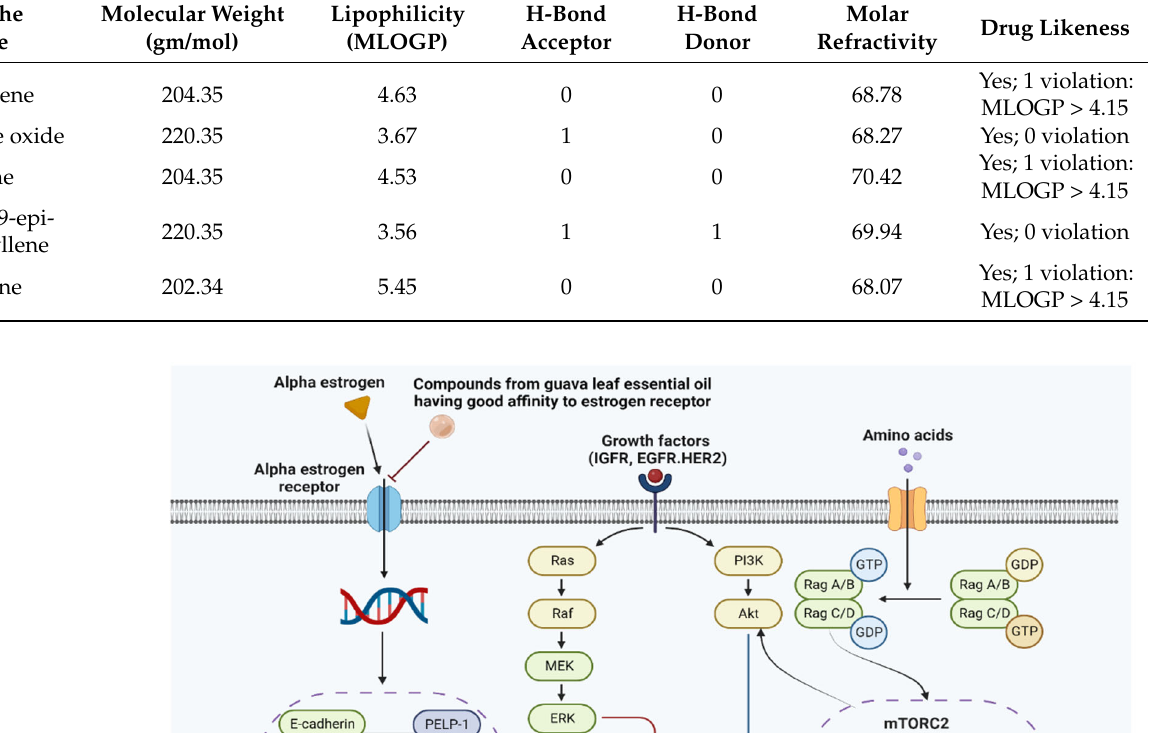
Table 6. Table showing the parameters for druglikeness of the selected ligands.